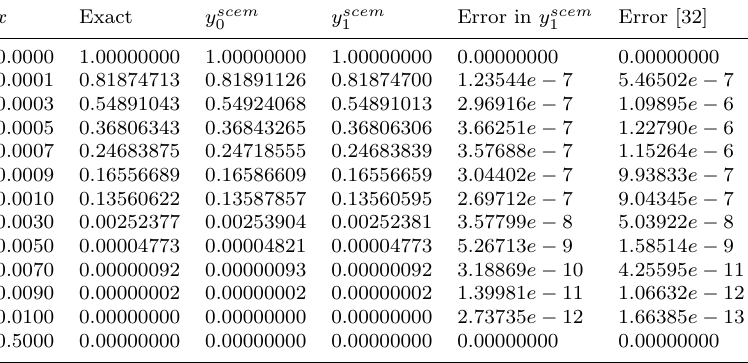
Comparison of the analytical solutions and SCEM approximations for solving Equations (4.1)–(4.2); ε = 0 .